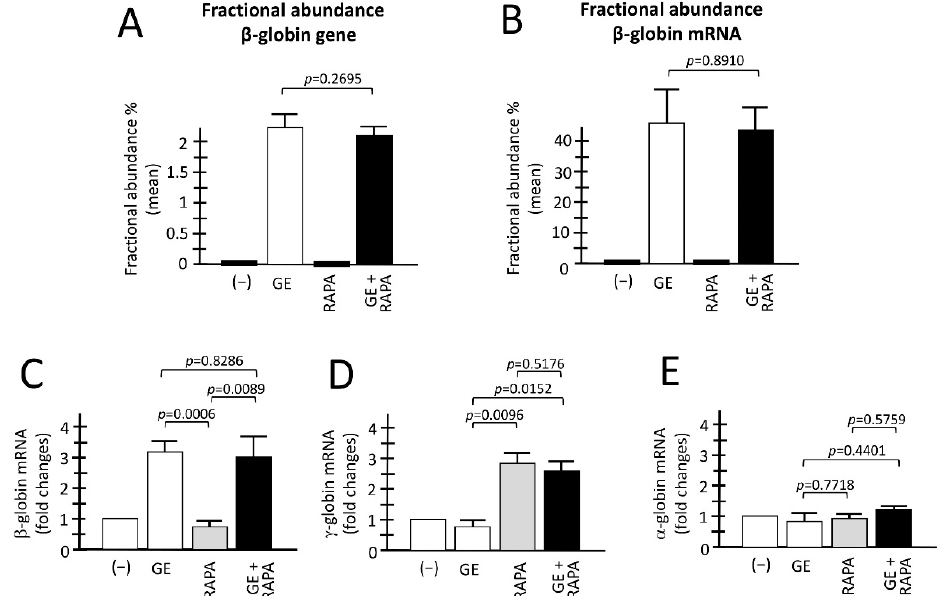
Figure 2. Evaluation of the combination between CRISPR-Cas9 gene editing and rapamycin-mediated HbF induction. ( A , B ) Fractional abundance obtained after treatment performed by CRISPR-Cas9 system on ErPCs isolated from β 0 39-thalassemia patients and analyzed by ddPCR assay. The histograms show the data related to β-globin gene ( A ) and β-globin mRNA ( B ). ( C – E ) The histograms show the relative content of the β-, γ- and α-globin mRNAs analyzed by multiplex RT-qPCR. (−): untreated cells; GE: cells treated with the CRISPR-Cas9 system; RAPA: rapamycin 200 nM treated cells; GE + RAPA: cells treated with the CRISPR-Cas9 system and cultured in the presence of rapamycin. All the data of RT-qPCR were normalized using GAPDH as housekeeping internal control gene, as described in Material and Methods. Results are expressed as fold changes with respect to control untreated cells (−). Results are from independent experiments using ErPCs cultures from three ( A ) and five ( B – E ) homozygous β 0 39-thalassemia patients. The level of statistical significance is reported as p -value ( p ).